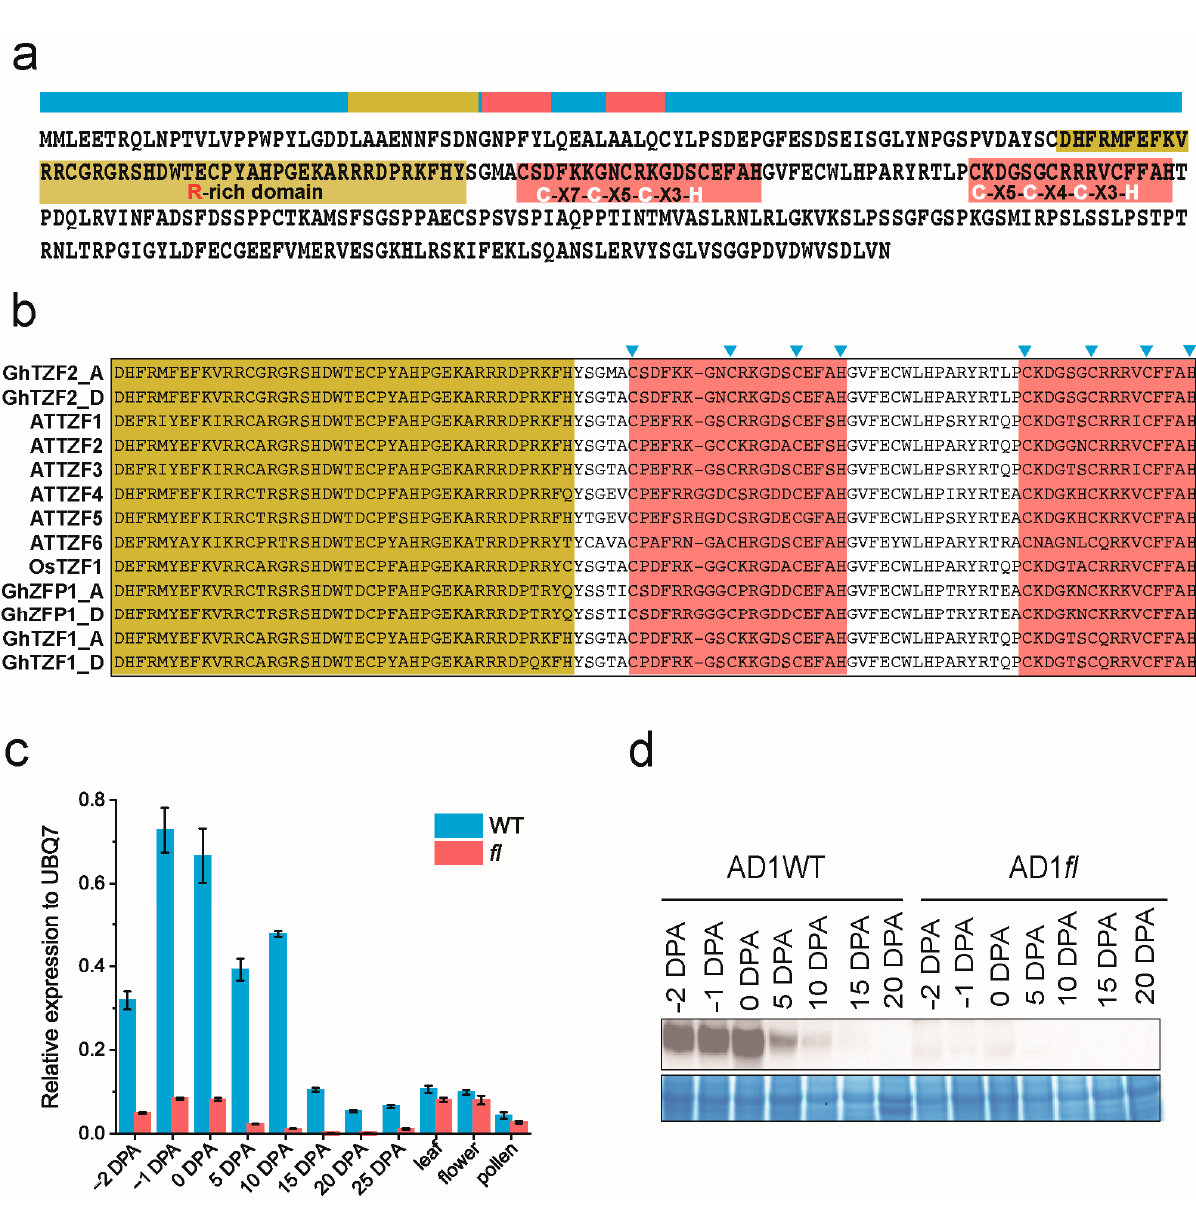
Figure 3. Structural features and expression pattern of GhTZF2 . ( a ) Schematic of GhTZF2 gene structure. The yellow boxes indicate the R-rich domain, and the amber boxes predict the CCCH zinc finger domains. ( b ) Multiple sequence alignments of GhTZF2 and other plant-specific TZF genes were reported in Arabidopsis , rice, and cotton using the DNAMAN program. A conserved R-rich domain and two CCCH domains are marked in the same colors in ( a ). Amino acids in CCCH domains were tagged by blue triangles. ( c ) Verification of the transcription level of GhTZF2 in ovules with or without fibers in different stages, and other tissues of WT and fl , was carried out via qRT-PCR. ( d ) Western blot analysis of ovules (with or without fibers) from different developmental stages between WT and fl. A positive band with an arrow indicates about 40 kDa. Total proteins in SDS/PAGE gels stained with Coomassie brilliant blue were taken as a control to show the same sample amount.